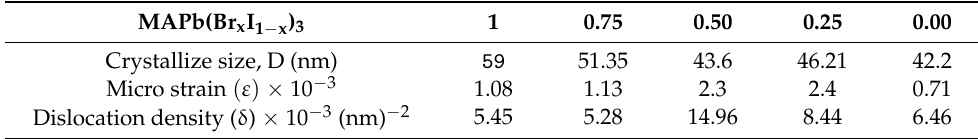
Table 2. The X-Ray diffraction parameters estimated from the W-H plot.